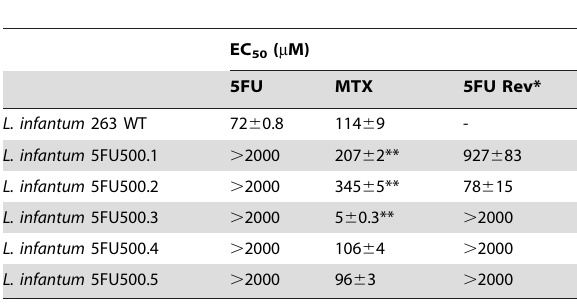
Nextera DNA sample prep kit (each strain tagged with a different Table 1. Resistance levels to 5-FU and MTX in L. infantum 263 WT and 5-FU resistant